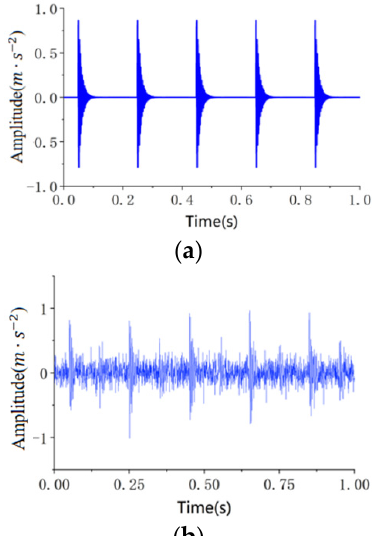
Figure 6. Time domain diagram of simulated signal. ( a ) time ‐ domain diagram of no ‐ noise, and ( b ) time domain diagram of noisy simulation signal.